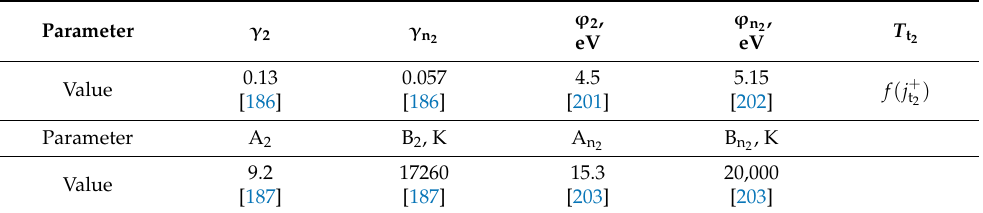
Table 4. Additional parameters of the model for reactive magnetron sputtering of a hot tantalum target in Ar + O 2